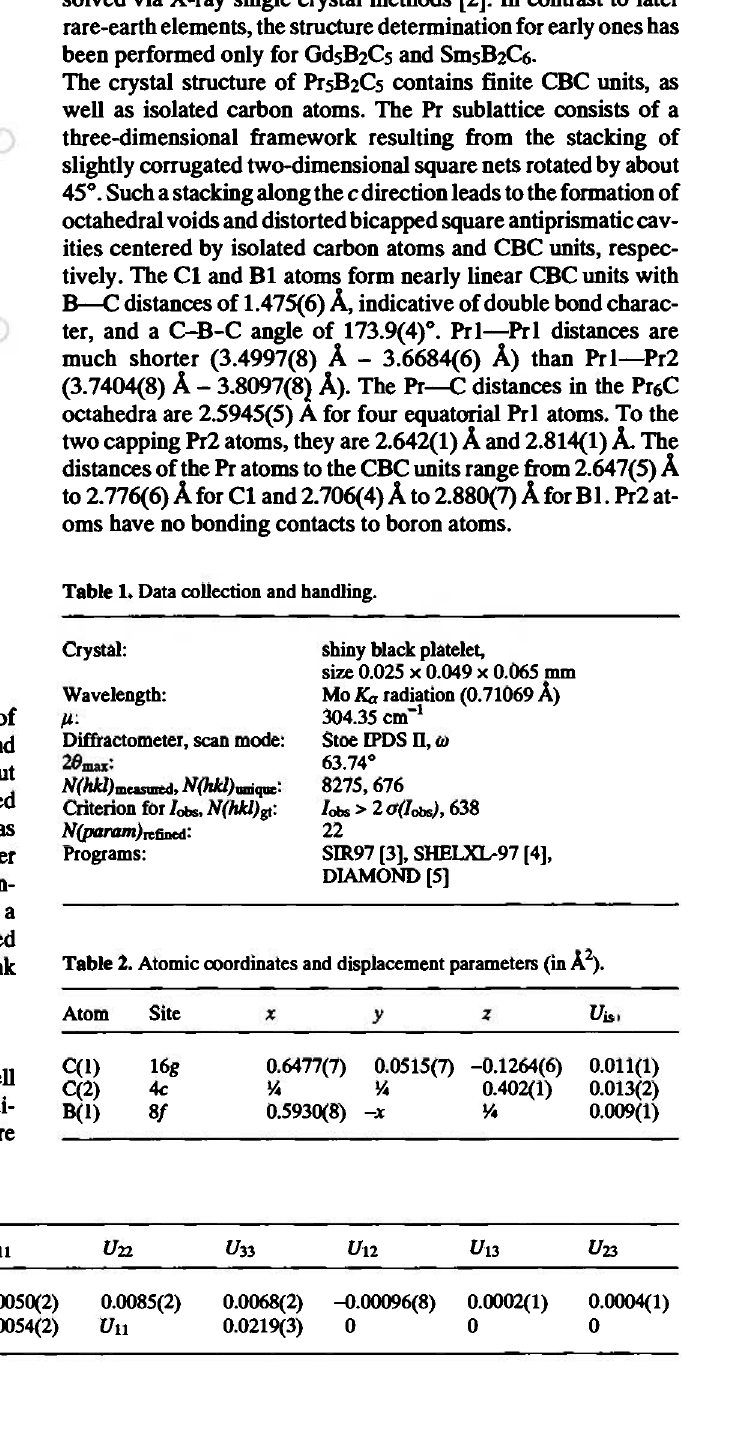
Table 3. Atomic coordinates and displacement parameters (in A 2